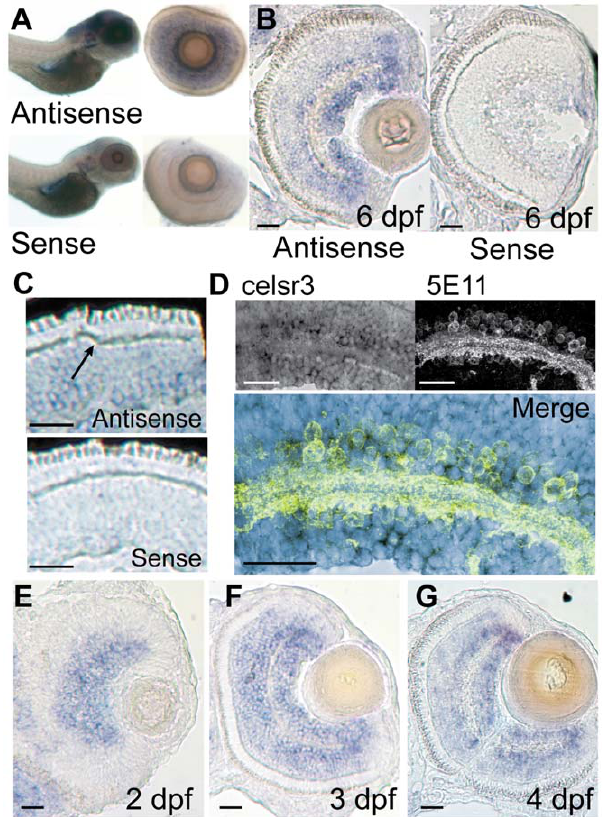
Figure 4. celsr3 is abundant within amacrine and ganglion cell layers of the retina. In situ hybridization was performed on WT animals using probes for exon1 of celsr3 . A) Whole mounts of 6 dpf fish show localization to the brain and eye. When eyes were removed they show localization in the INL and ganglion cell layer. B and C) Cryosections of a 6 dpf eye show staining in the INL with abundance in the amacrine and ganglion cell layers. Sense controls show no staining. Arrow in C points to unlabeled horizontal cells. D) Slides were probed for celsr3 message and then probed with the anti-amacrine antibody 5E11 confirming presence of the message within amacrine cells. E–G) A time series of celsr3 message localization shows accumulation around the IPL at all ages from 2–4 dpf. Scale bars are 20 m m.